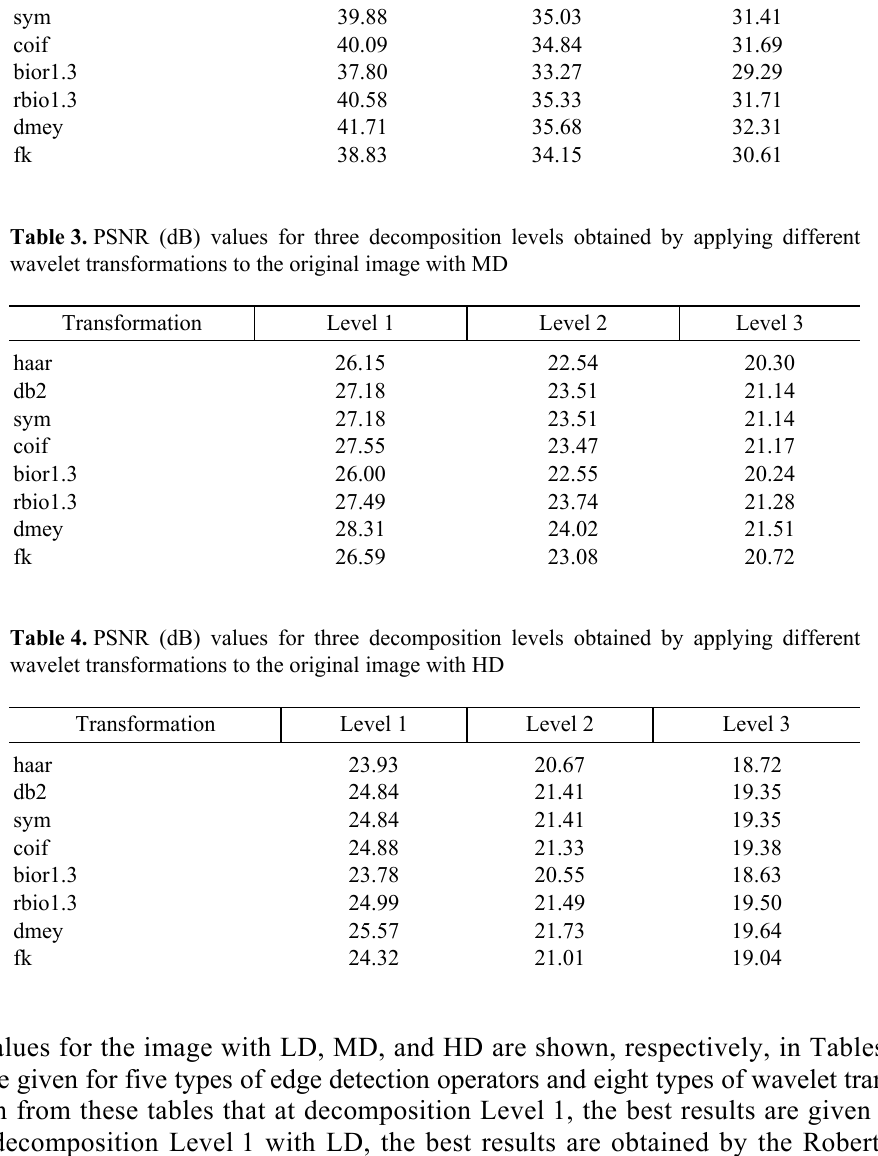
Table 2. PSNR (dB) values for three decomposition levels obtained by applying different wavelet transformations to the original image with LD Transformation Level 1 Level 2 Level 3 haar